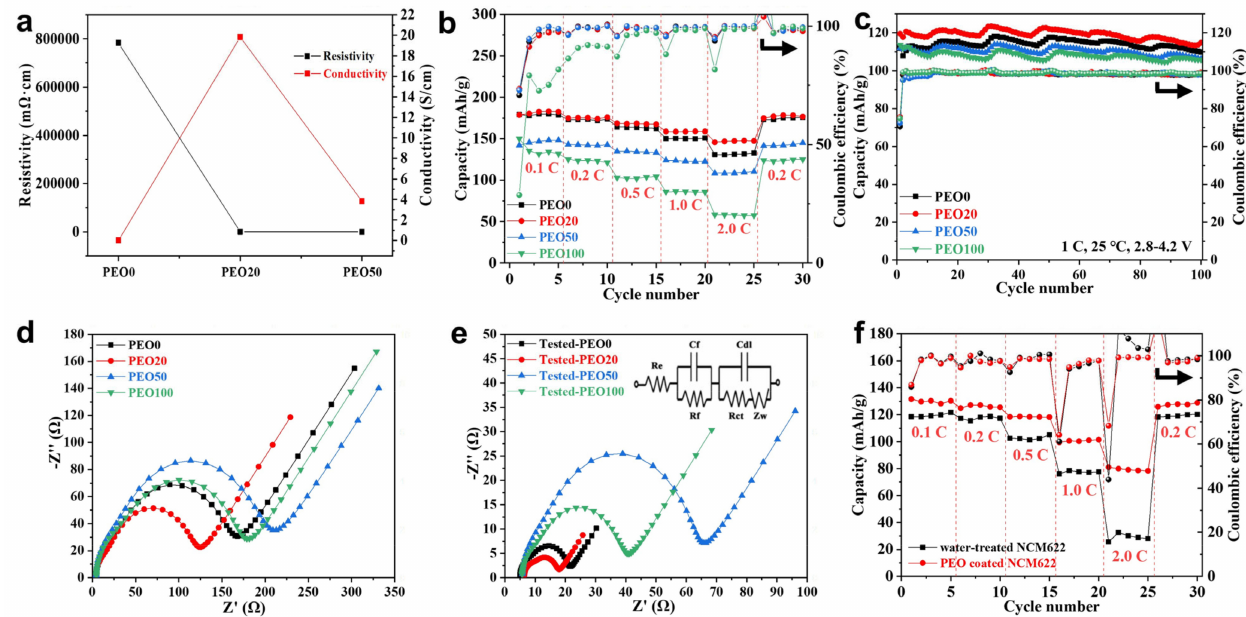
Figure 5. ( a ) Electronic resistivity and conductivity of the PEO0, PEO20 and PEO50 electrodes; ( b ) rate performance of the NCM622/Li batteries; ( c ) cycling performance of the NCM622/Li batteries at 1 C; electrochemical impedance spectra of the batteries ( d ) before and ( e ) after the 100 charge – discharge test (The inset in ( e ) is an equivalent circuit model for the half-cells); ( f ) rate performance of the NCM622/Li batteries using water-treated NCM622 particles and PEO-coated NCM622 particles,